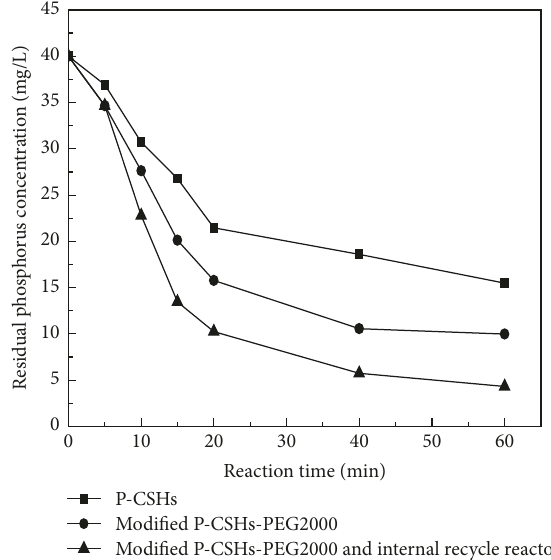
Figure 10: Comparing the three systems for phosphorus recovery (initial concentration of phosphorus,40 mg/L; initial pH, 7.0; dosage of crystal, 1.0g/L; stirring speed, 80